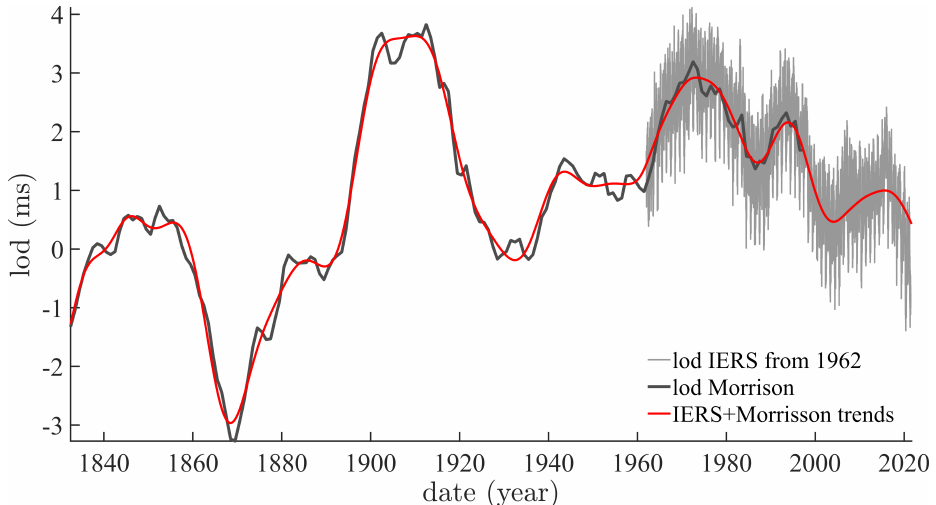
Figure 2. Monthly values of length of day data (LUNAR97, 1832–1997; bold black curve) from Gross [23] and daily values (1962–Present, gray curve) from IERS . Superimposed are their trends as determined by SSA (LUNAR97 + IERS = red